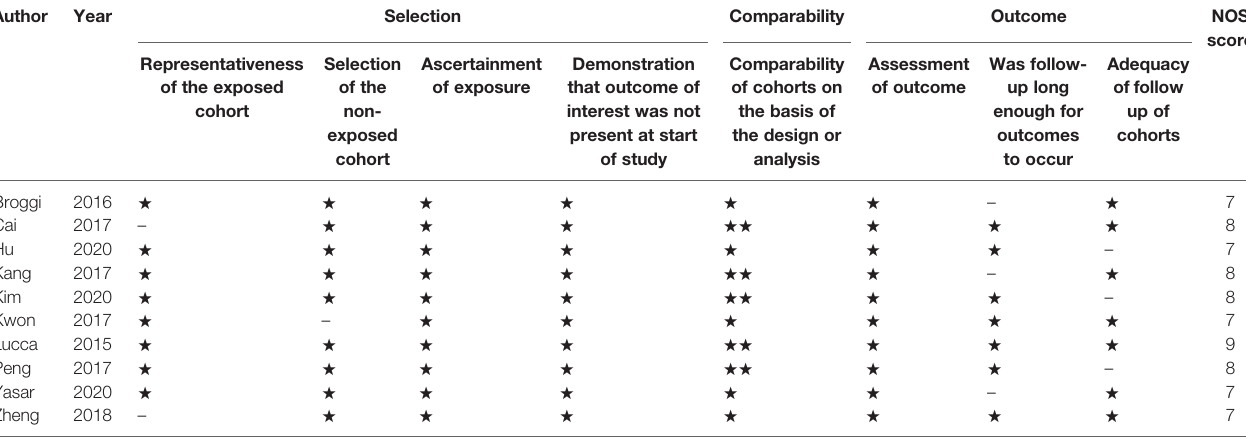
NOS, Newcastle-Ottawa Scale. A star represents one point.